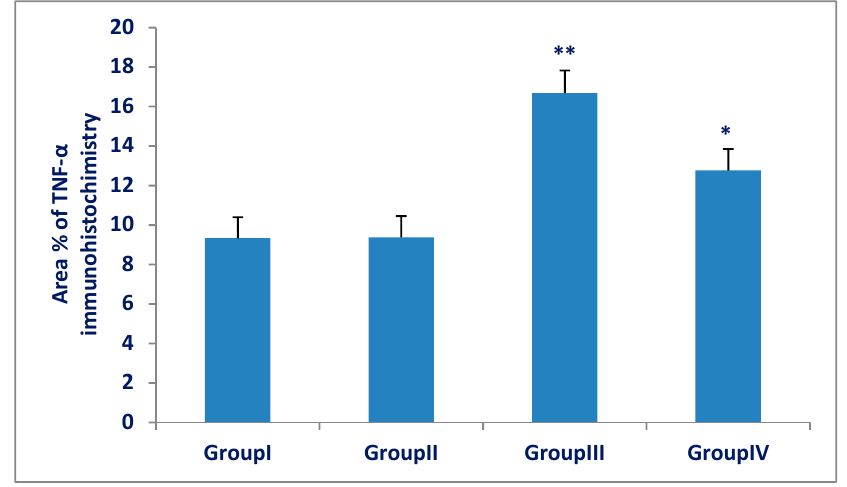
Figure 9. Area percentage of TNF- α of spleen in group (III) (Olanzapine-treated group) was significantly increased compared to group (I) (control group). A significant decrease in group (IV) (Olanzapine and vitamin C) as compared to group (III). The differences in area percentage of TNF- α between group (I) and group (II) were not significant ( p > 0.05). Results are expressed as mean ± SD and the level of significance was set for p -values less than 0.05. **: significant increase, group (III) versus group (I) ( p < 0.001). *: significant decrease, group (IV) versus group (III) ( p < 0.001).